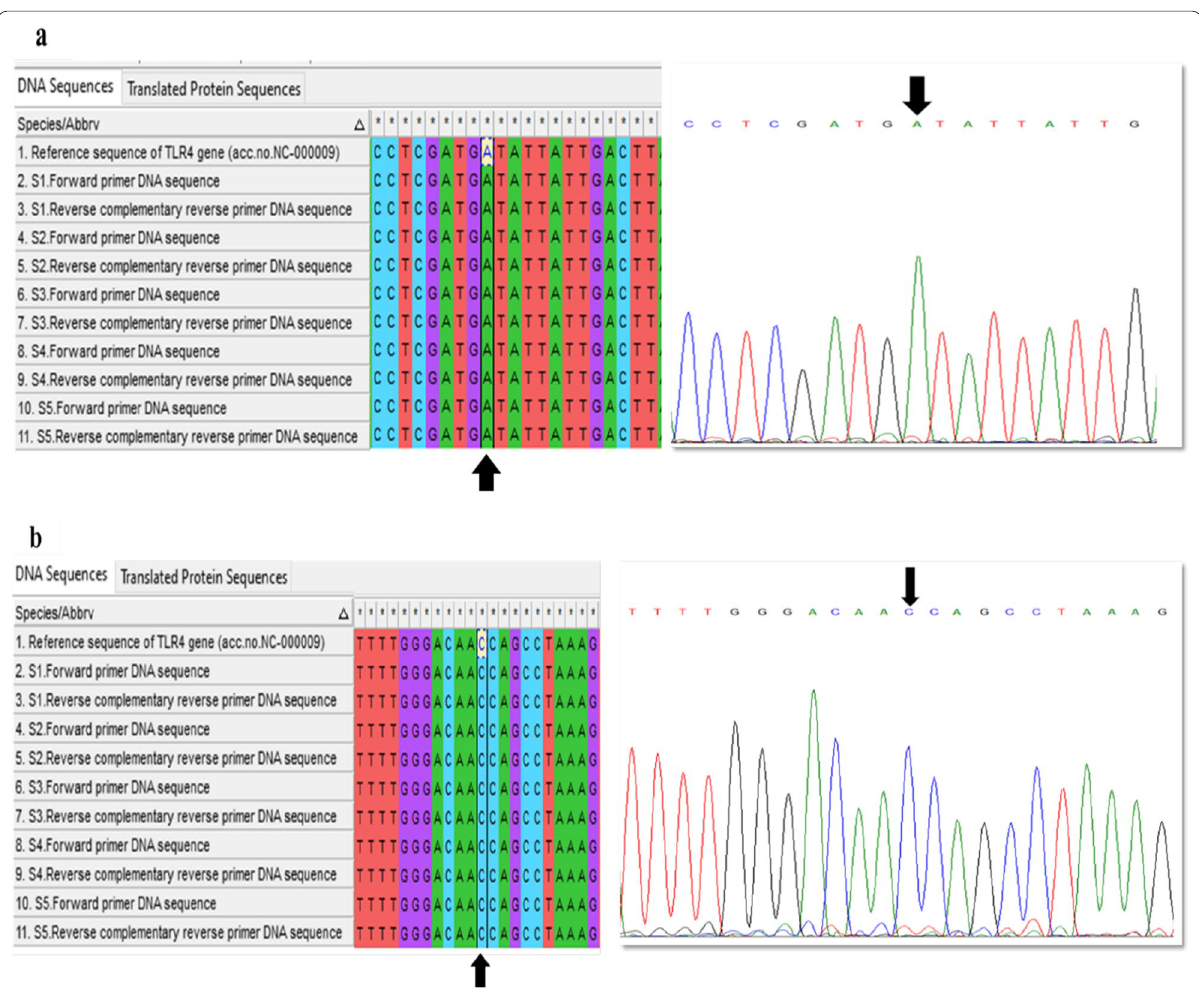
Fig. 3 Multiple sequence alignment of TLR4 gene sequences and a representative sequence chromatogram for each SNP visualized by Mega X software. a TLR4 c.896AA genotype, b TLR4 c.1196CC genotype. Each of the included five samples was represented as forward and reverse DNA sequences (the latter in the reverse complementary form) for each genotype, and the location of the nucleotide in each SNP was determined based on the database sequence of the TLR4 gene (AC; NC-000009), and it was highlighted by the black arrow in each SNP